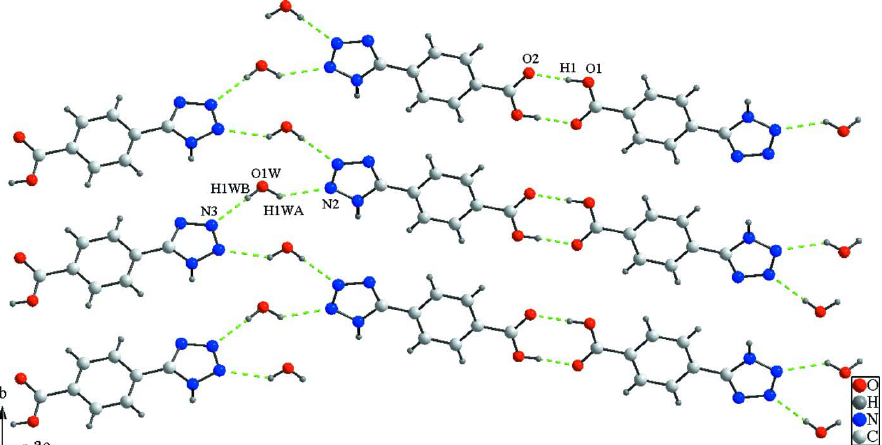
Figure 2 Packing of (I) into two-dimensional layers linked by O—H···N and O—H···O hydrogen bonds (green dashed